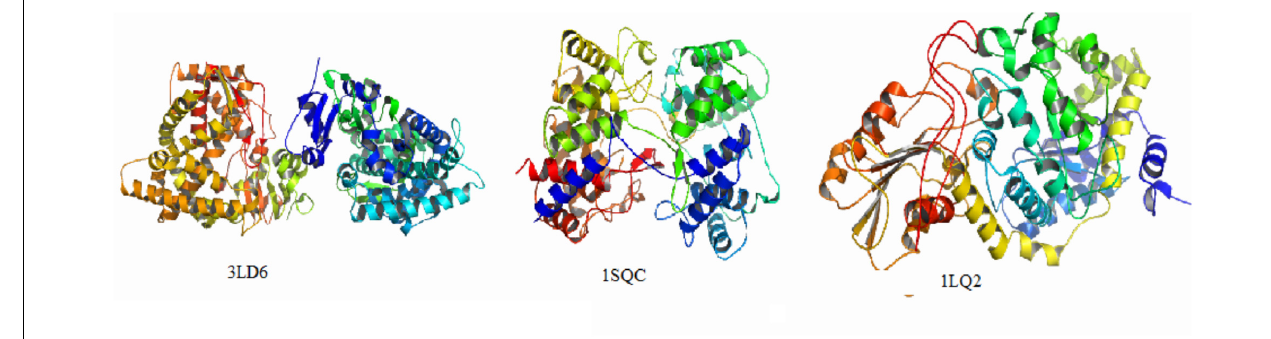
FIGURE 5 | Enzyme crystal complexes of 3LD6, 1SQC, 1LQ2. TABLE 4 | − CDOCKER energy of compounds to three enzymes.